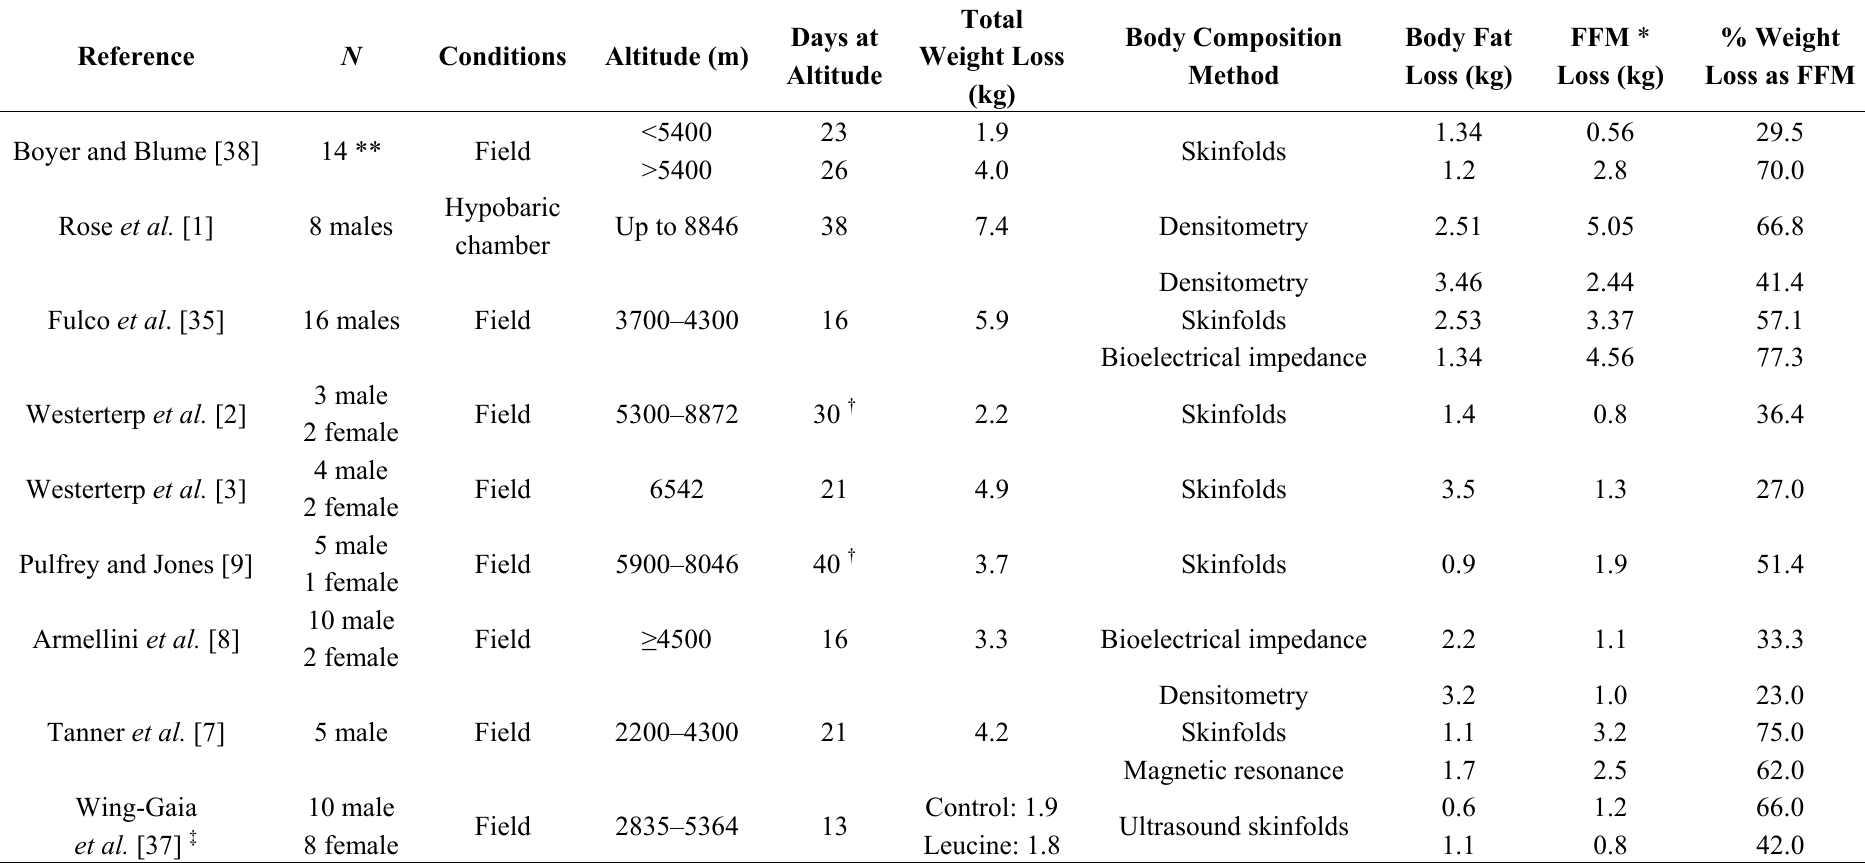
Table 1. Body composition changes at